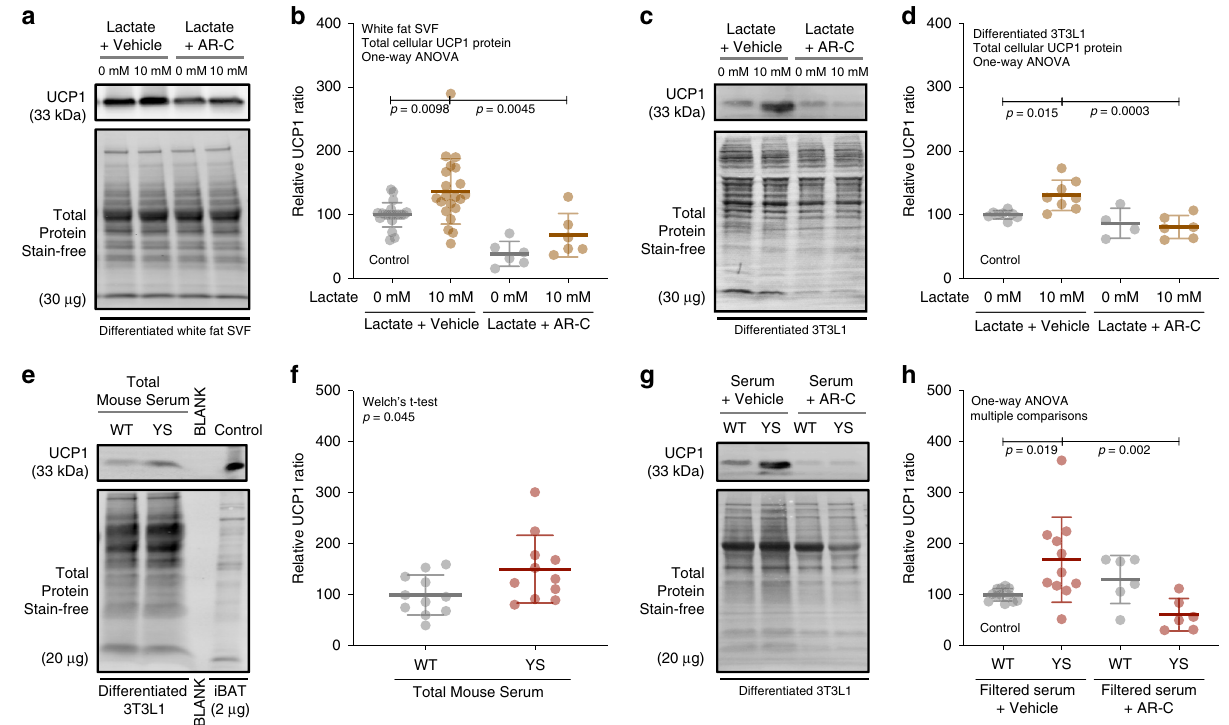
Fig. 8 Lactate promotes brown adipogenesis in white preadipocytes. a , b Representative immunoblots ( a ) and relative protein levels ( b ) for mitochondrial uncoupling protein UCP1 in differentiation assay of inguinal white adipose tissue (iWAT) SVF cells treated with vehicle ( n = 21), lactate ( n = 21), MCT1/2 inhibitor ( n = 6) or both ( n = 6). c , d Representative immunoblots ( c ) and relative protein levels ( d ) for UCP1 in differentiation assay of 3T3-L1 preadipocytes treated with vehicle ( n = 8), lactate ( n = 8), MCT1/2 inhibitor ( n = 4) or both ( n = 6). e , f Representative immunoblots ( e ) and relative protein levels ( f ) for UCP1 in differentiation assay of 3T3-L1 preadipocytes treated with un fi ltered serum (10%) from WT ( n = 11) or YS ( n = 11) mice. g , h Representative immunoblots ( g ) and relative protein levels ( h ) for UCP1 in differentiation assay 3T3-L1 preadipocytes treated with 10 kb- fi ltered serum (20%) from WT and YS mice, with (WT, n = 12, YS, n = 11) or without (WT, n = 6, YS, n = 6) the MCT1/2 inhibitor. P values are indicated as analyzed by ordinary one-way analysis of variance (ANOVA) with Dunnett ’ s multiple comparisons test ( b , d , h ), Welch ’ s t test ( f ). All statistical tests are two-sided. Data are represented as mean ± standard deviation. Relative protein levels are determined as protein levels normalized to vehicle ( a , b ) or wild-type mouse serum ( f , h ) treated controls. Source data are provided as a source data fi